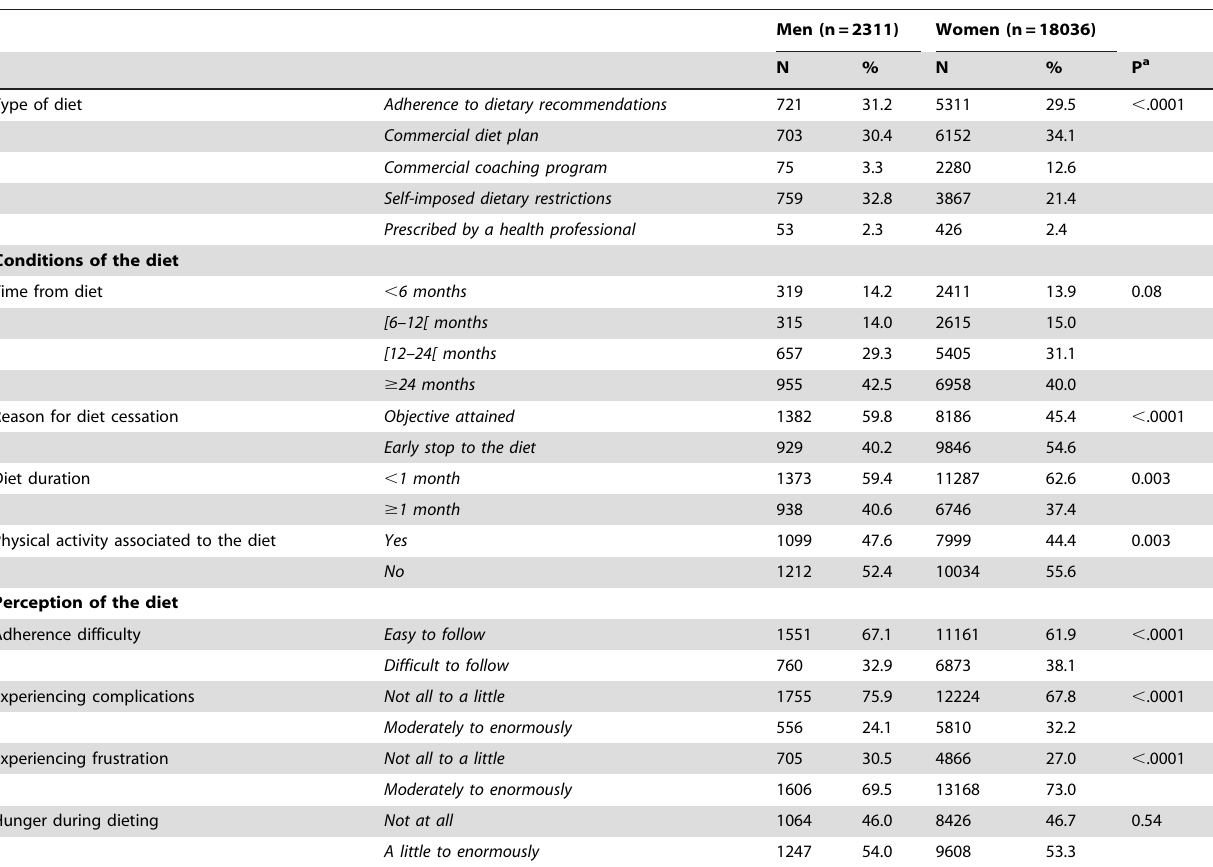
Table 2. Characteristics of the diets